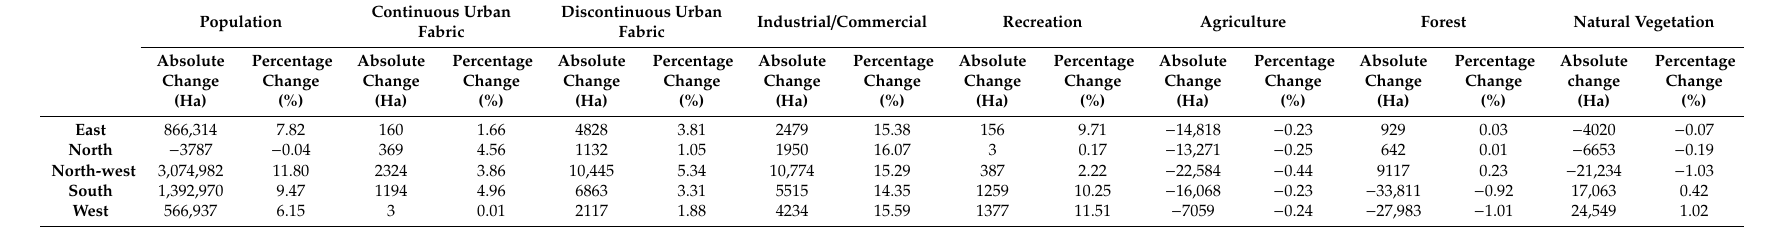
Table 5. Regional dynamics for land-use and population between 2006 and